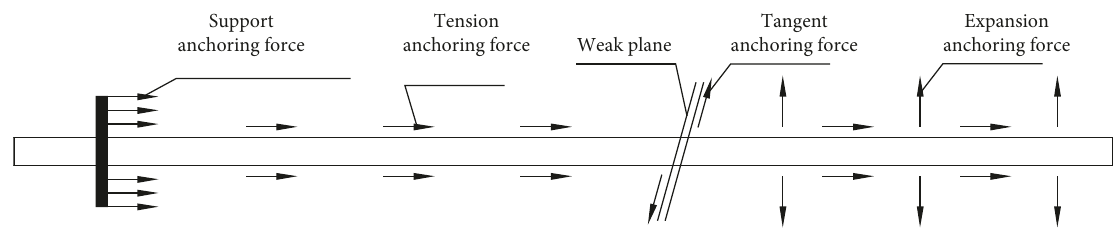
Figure 15: Anchoring force of the inflatable retrievable anchor.